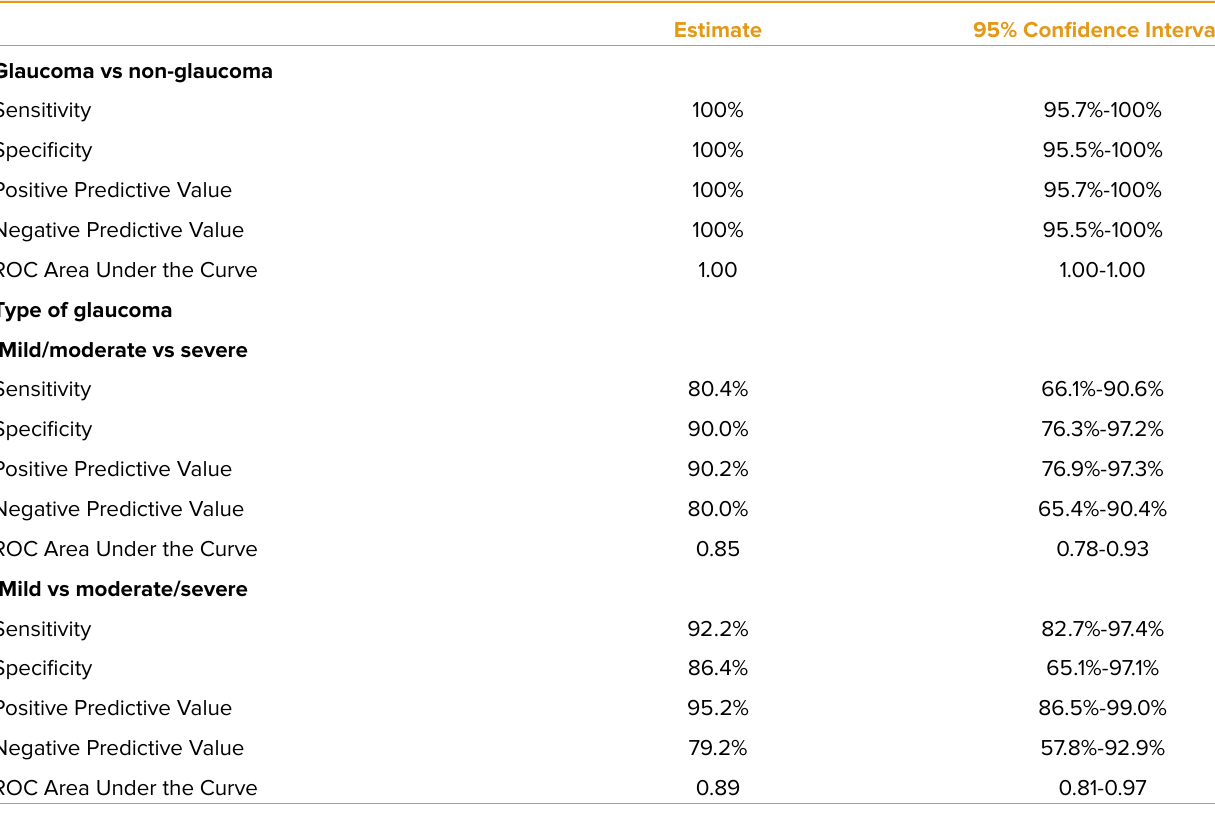
Table 1. Table showing the diagnostic test properties (including the Area Under the Curve) of the Palm Scan VF2000 ® Virtual Reality Visual Field Analyzer in 166 eyes.